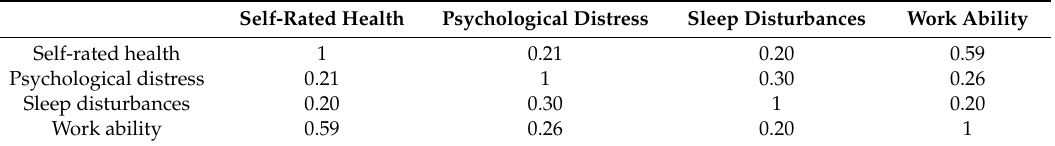
Table 3. Correlations of wellbeing scores (Finland, 2012). Self-Rated